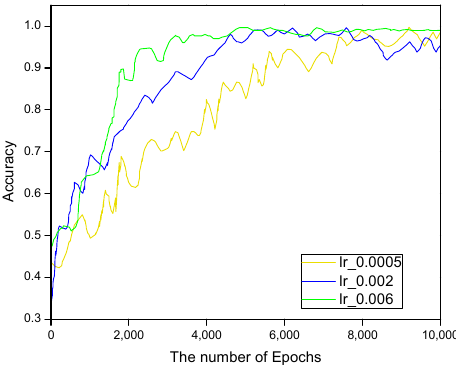
Figure 8. Accuracy under different learning rates.